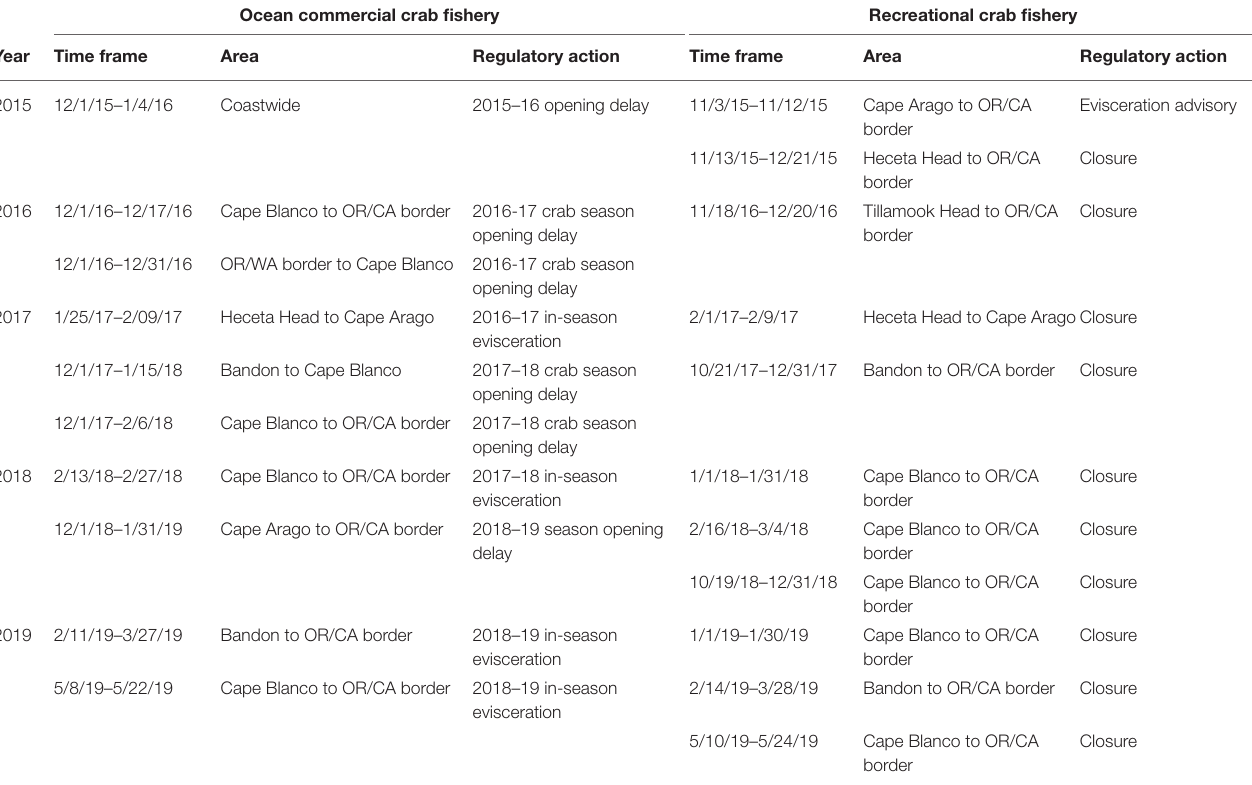
TABLE 1 | Oregon State harvest actions due to elevated domoic acid in Dungeness crab viscera